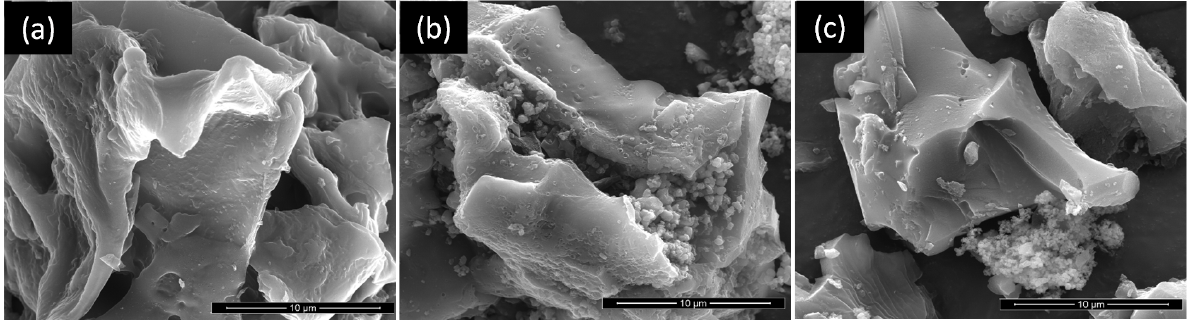
Figure 3. SEM images of ( a ) AC, ( b ), TiAC29, and ( c ) TiAC60.